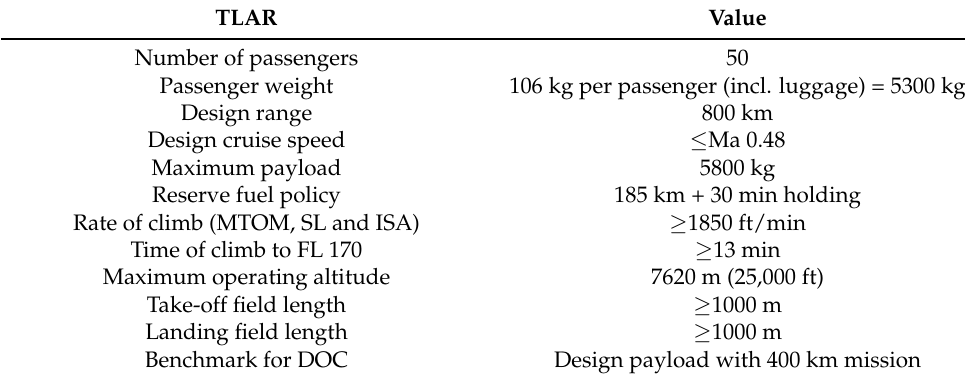
Table 1. Top level aircraft requirements